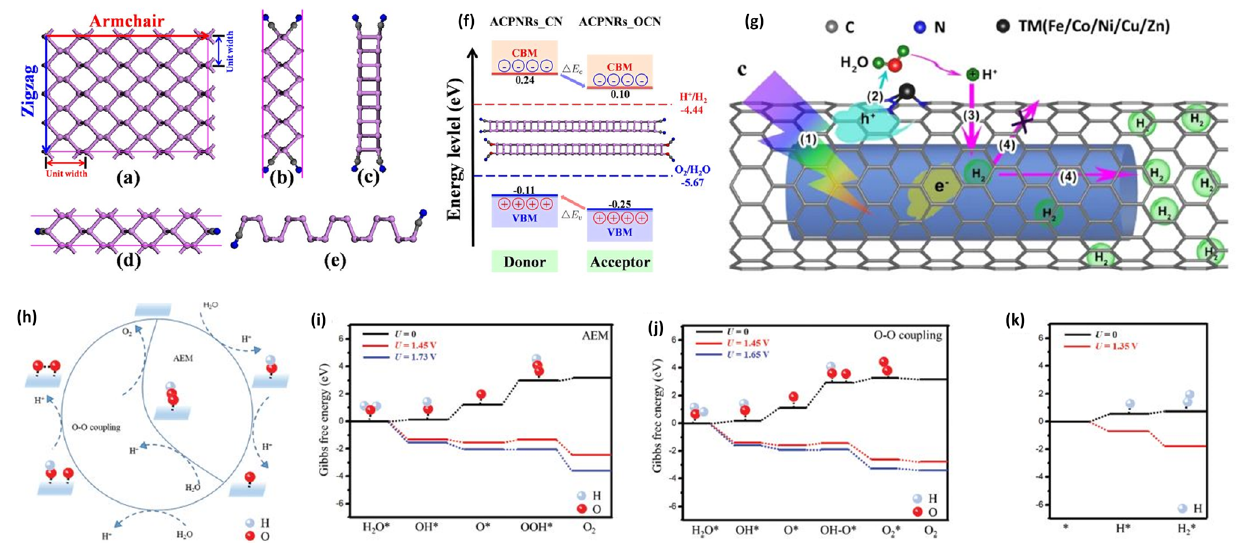
Figure 13. Geometric structures of pristine phosphorene and edge modified PNRs: ( a ) phosphorene in a 4 × 4 supercell; ( b , c ) top and side views of ACPNRs passivated by nitrile (CN) functional group in ribbon width of 4 (ACPNR4_CN); ( d , e ) top and side views of ZZPNRs by nitrile (CN) active group in ribbon width of 4 (ZZPNR4_CN). ( f ) Schematic illustration of type-II donor−acceptor band alignments edge modified PNR heterobilayers. Reprinted with permission from ref. [265]. Copyright 2017 ACS. ( g ) Photocatalytic hydrogen generation and collection scheme. Reprinted with permission from ref. [268]. Copyright 2019 ACS. ( h ) Reaction mechanism for two possible mechanisms of the OER via single-site or dual-site reactions on F-10BN_ZZ-GDYNR1 (GDYNR stands for graphdiyne nanoribbons). Reaction energy pathways of ( i ) the OER following the AEM mechanism, ( j ) the OER through the O–O coupling mechanism, and ( k ) the HER on F-10BN_ZZ-GDYNR1 under different electrode potentials U relative to SHE at pH = 7. Reprinted with permission from ref. [269].